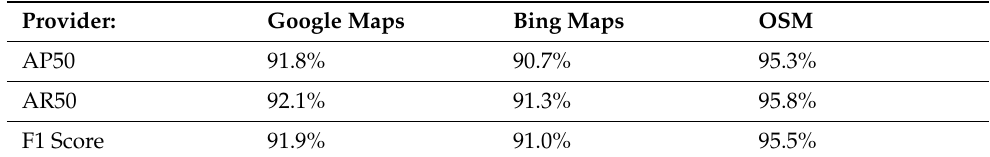
Table 3. Experiment #2—performance summary.